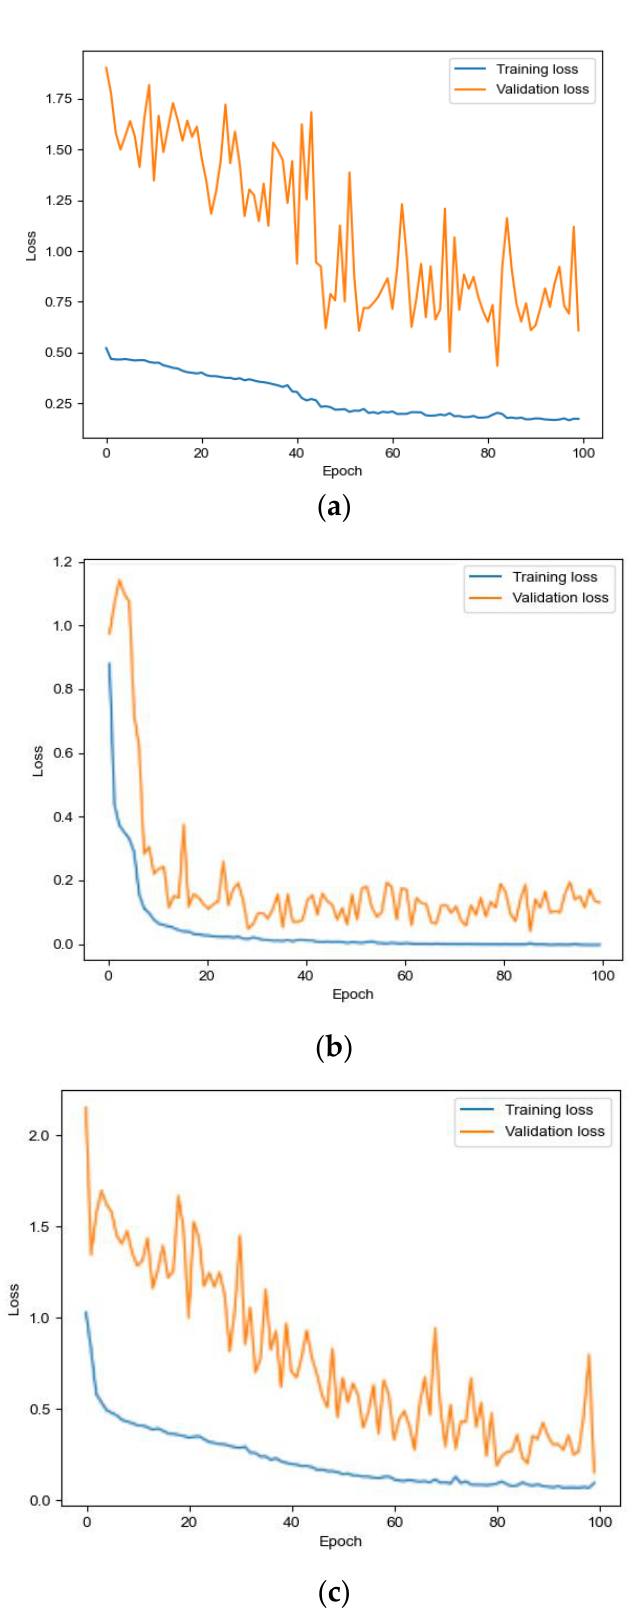
Figure 4. Training/validation loss per epoch using the LSTM-based variant for time slice classification on: ( a ) UAH, ( b ) MOTIF 1 and ( c ) MOTIF 2 datasets.